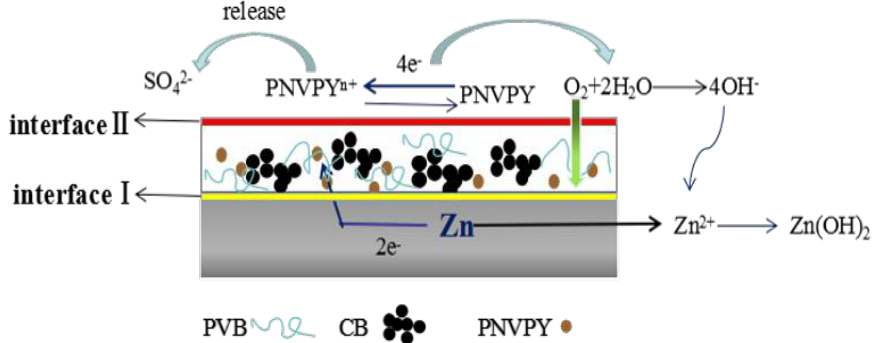
Figure 9. The illustration of the corrosion mechanism of the PNVPY/CB/PVB composite coating.